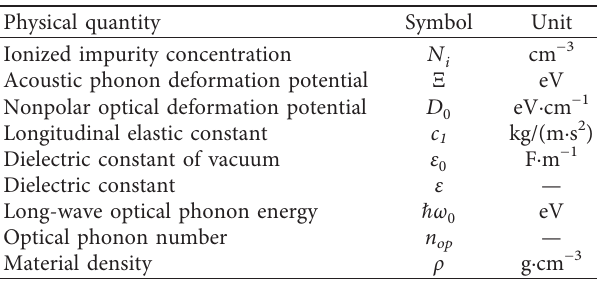
Figure 3: Strained Ge conduction band energy valley energy levels and effective electron mass diagrams. Table 2: Parameter table of scattering